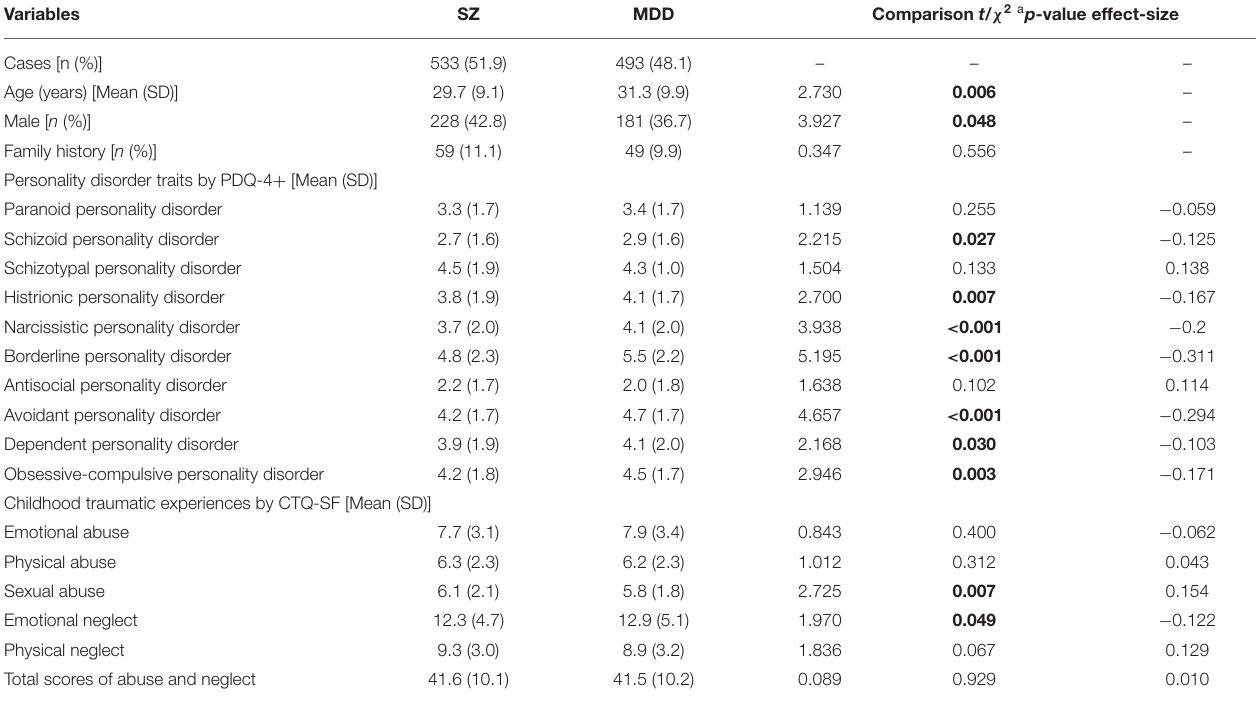
TABLE 1 | Demographic characteristics, personality disorder traits, and childhood traumatic experiences in patients with schizophrenia and major depressive